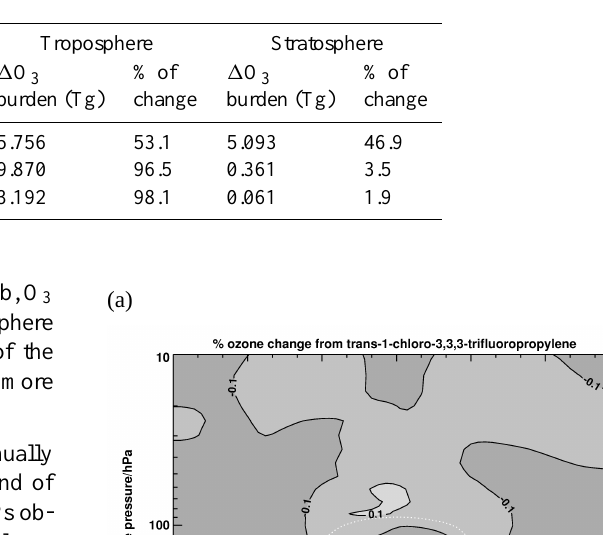
Table 4. Annually averaged, global tropospheric and stratospheric ozone burden changes (Tg) calculated in MOZART 3 for surface fluxes of tCFP and of tDCE.